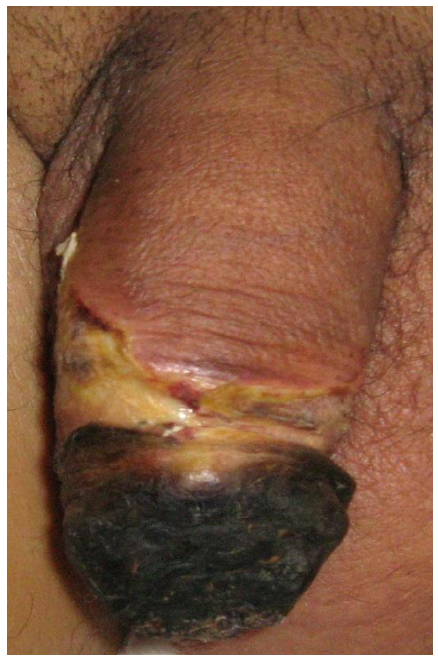
FIGURE 1. Calciphylaxis mimicking penile gangrene.